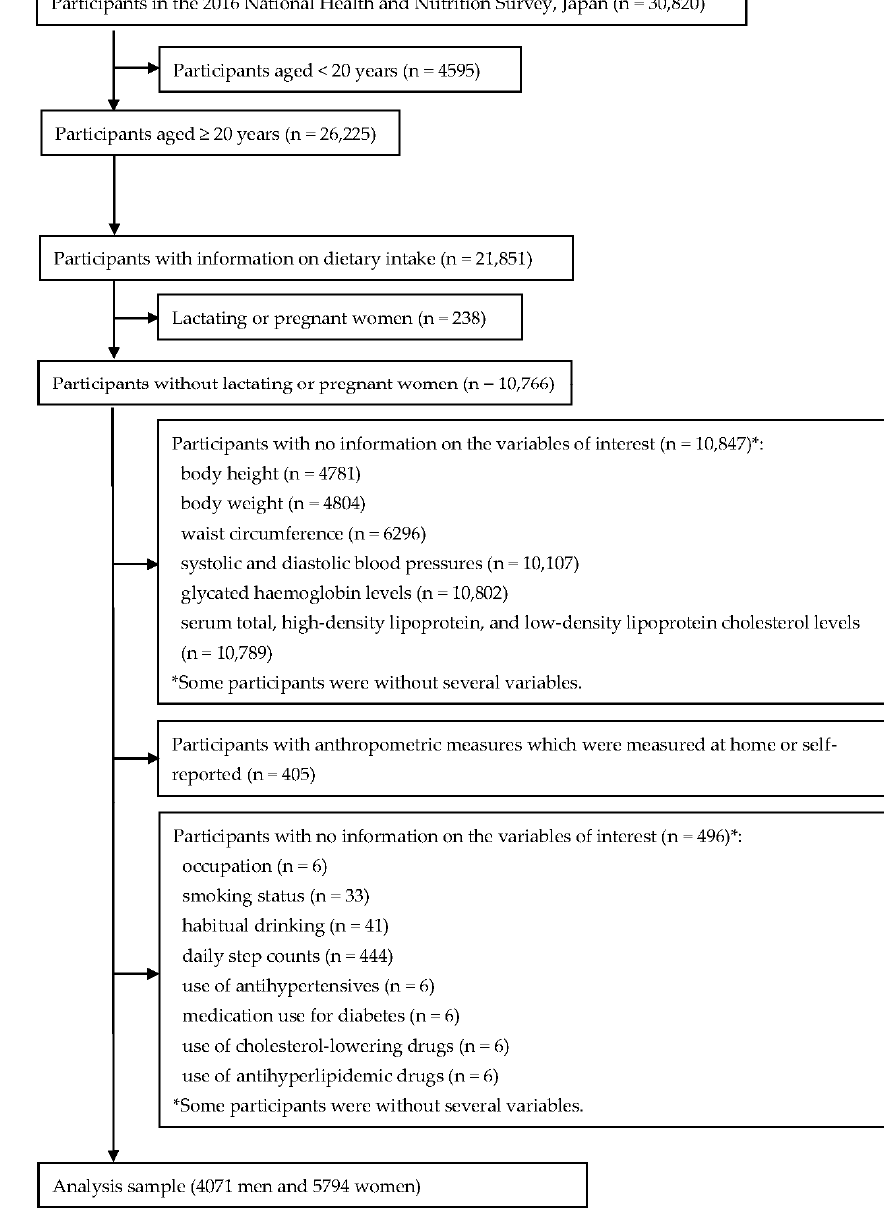
Figure 1. Flowchart of participants included in the present analysis.